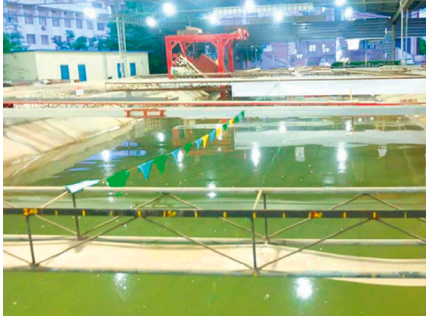
Figure 3: River channel model. Table 1: Primary parameters of the